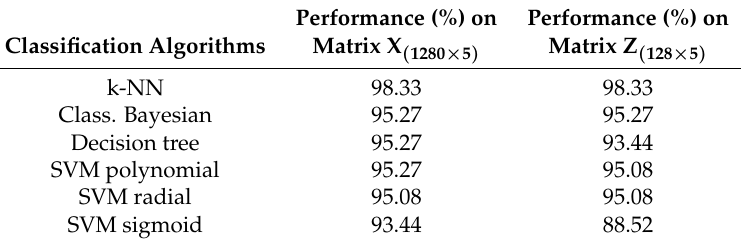
Table 3. Performance of the considered classification algorithms.